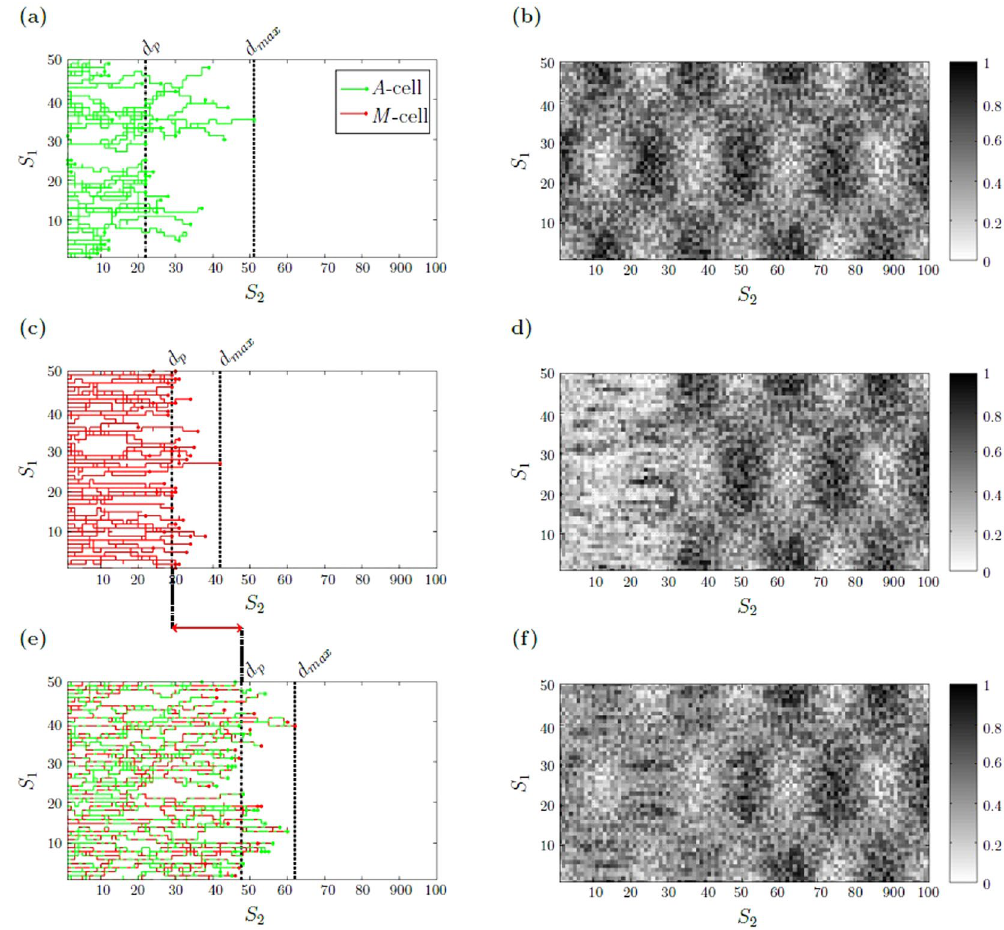
Figure 6. Individual cell trajectories under heterogeneous ECM conditions with small migration rate ratio. Individual cell trajectories ( a,c,e ) are visualized together with the ECM resistance distribution ( b,d,f ) after 200 Monte Carlo steps. A -cells and their trajectory are color indicated by green, M -cells by red. ( a ) non-switching cell population with γ = 0 (pure A -cell population) for which ( b ) the ECM after the cell migration has not being changed. ( c ) non-switching cell population with γ = 1 (pure M -cell population) with ( d ) corresponding ECM after cell migration. ( e ) switching cell population with α β = / 1 and ( f ) corresponding ECM. The vertical dashed lines in ( a ), ( c ) and ( e ) mark the average distance d p , the dotted line specifies the maximum migration distance between the maximum average migration distance d p of the d max . The red arrow indicates the difference Δ d p switching population and the non-switching population with γ = 0. The initial ECM resistance distribution is modeled by equation (2) with θ = 0.5, see Fig. 3(e). Simulation parameters are c M / c A = 0.25, κ = 0.01, δ = 0.1. Supplementary movies of the cell population trajectories can be found the supplementary